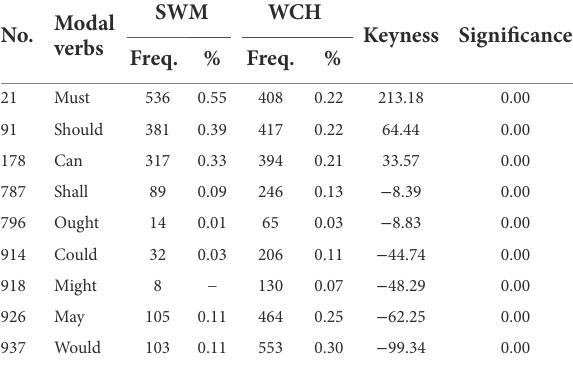
TABLE 12 Key modal verbs in SWM (in comparison with WCH).